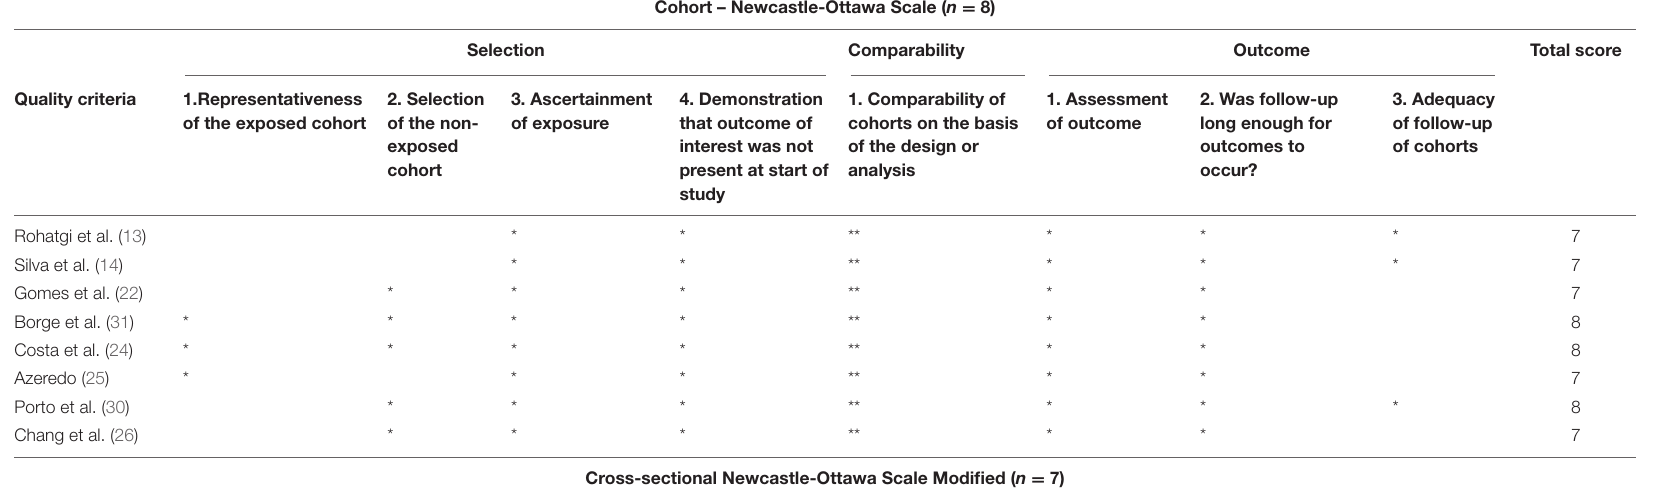
TABLE 3 | Methodological quality assessment and characteristics of the studies included in the